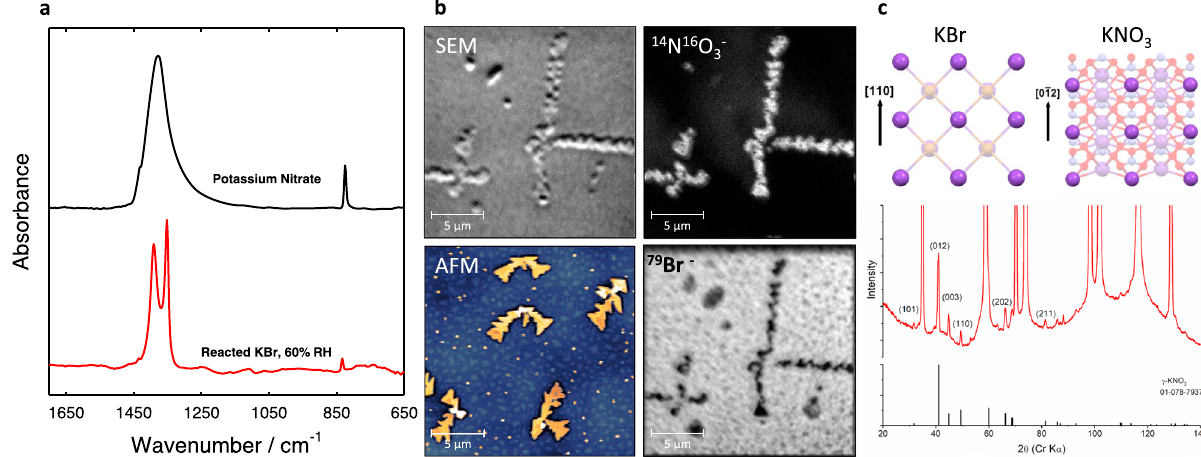
Fig. 2 Analysis of KBr crystals after irradiation con fi rm the presence of γ -KNO 3 . IR absorption bands at 1391, 1352, and 833 cm − 1 of the irradiated KBr were consistent with KNO 3 powder standards and reported stretching and bending vibrational modes of KNO 3 crystallites 34,44 . IR bands characteristic of individual NO 3 − ions, produced on X-ray and gamma-ray irradiated alkali halide surfaces in air 21,22,30,34 , were also present ( a ). Nano-SIMS analysis of an irradiated KBr sample con fi rmed crystallites contain higher concentrations of NO 3 − ions, and lower concentrations of Br − ions ( b ). The µ XRD pattern for the irradiated sample exhibited intense peaks corresponding to the KBr substrate and weaker peaks corresponding to surface growths, which were identi fi ed as the trigonal, (also gamma or phase III) form of KNO 3 ( c ). The lattice vectors marked in ( c ) are their projections in the plane of the fi